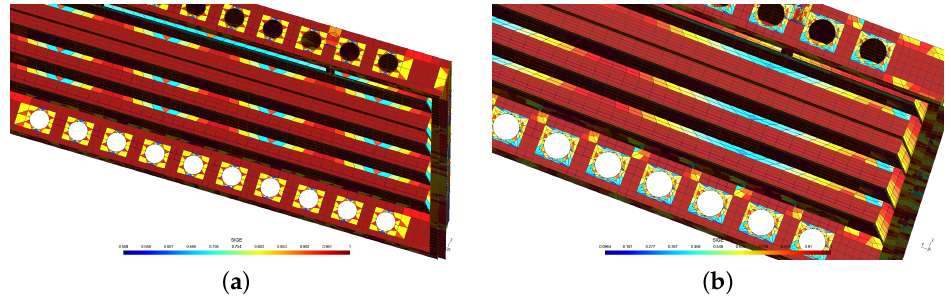
Figure 5. A comparison of the meshes for a web surface with openings from the geometry G 2 . We see that the full recombination algorithm produces an almost fully quadrilateral mesh, but the quality of the mesh, as measured by the SIGE indicator, for the full recombination algorithm is lower. In ( a ), we have the mesh generated by pyREMAKmsh and in ( b ) the fully recombined mesh.